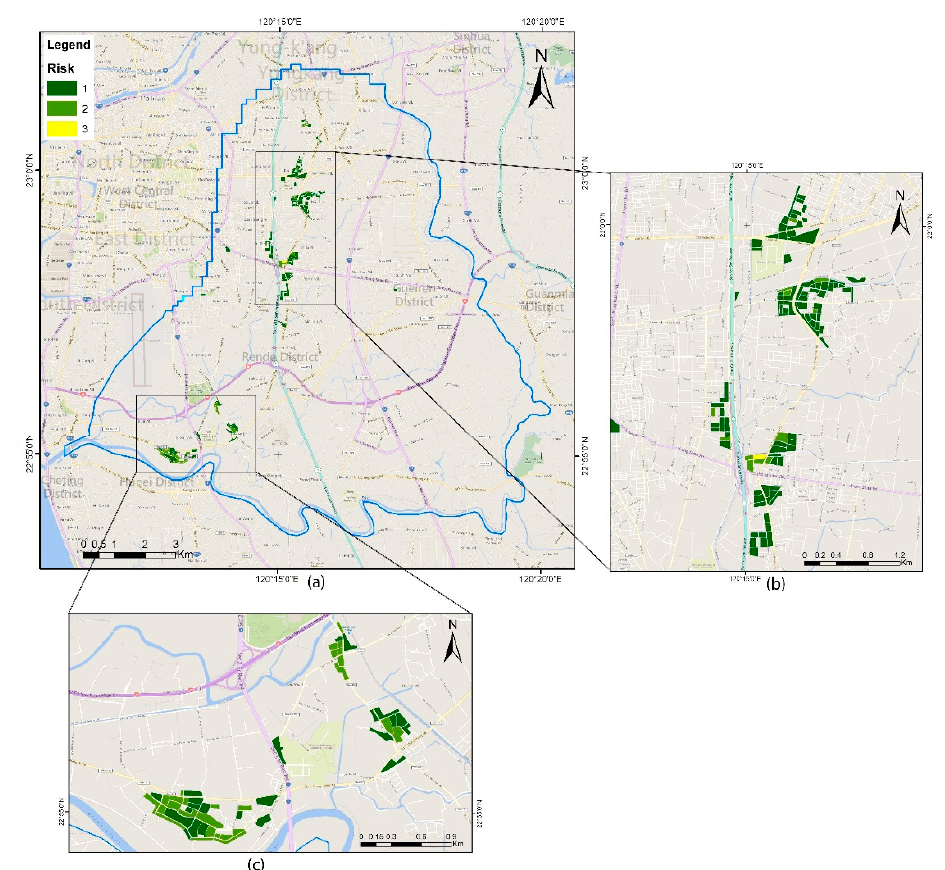
Figure 8. Risk map in a residential area: ( a ) risk in the entire study area, ( b ) details in the Rende District, and ( c ) details in the South